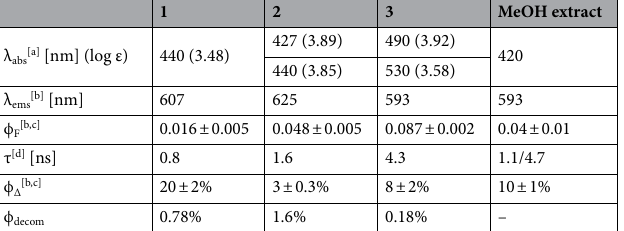
Table 3. Photochemical properties of 1 – 3 in methanol. [a] In MeOH [b] In air-saturated D 4 MeOH [c] Relative measurement using [Ru(bpy)